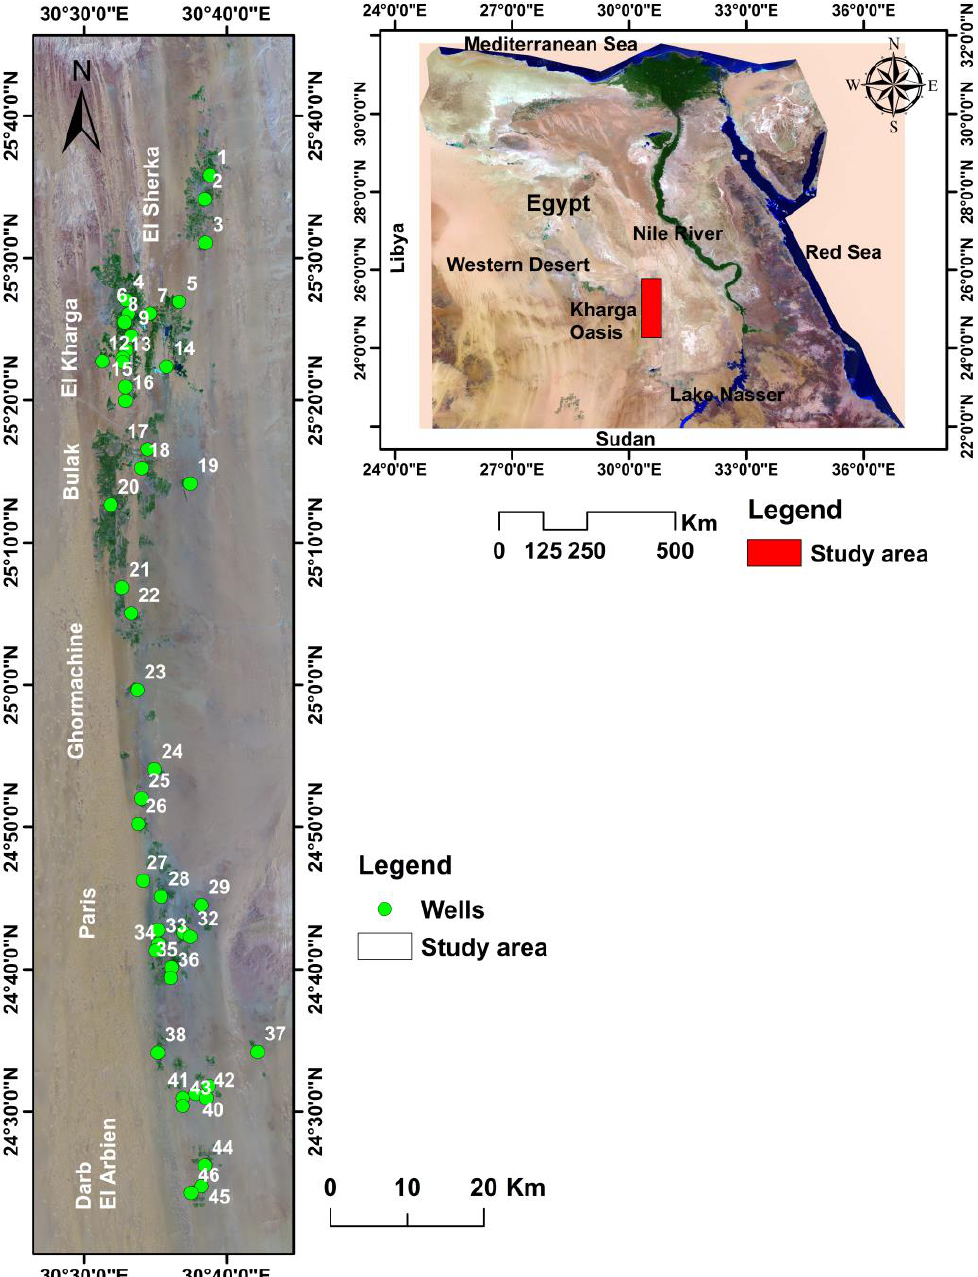
Figure 1. Location of the study area and pumping test wells.